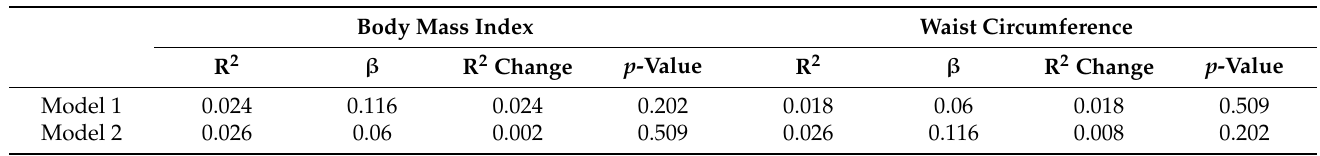
Table 5. Standardized regression coefficients examining the association of BMI and WC with clustered metabolic risk in the Caucasian